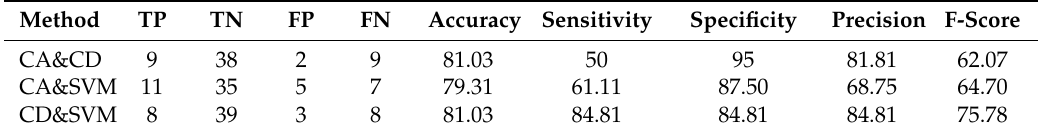
Table 8. Comparison between CA, SVM, and CD methods for TCFA detection (TP: true positive, FP: false positive, FN: false negative, TN: true negative).